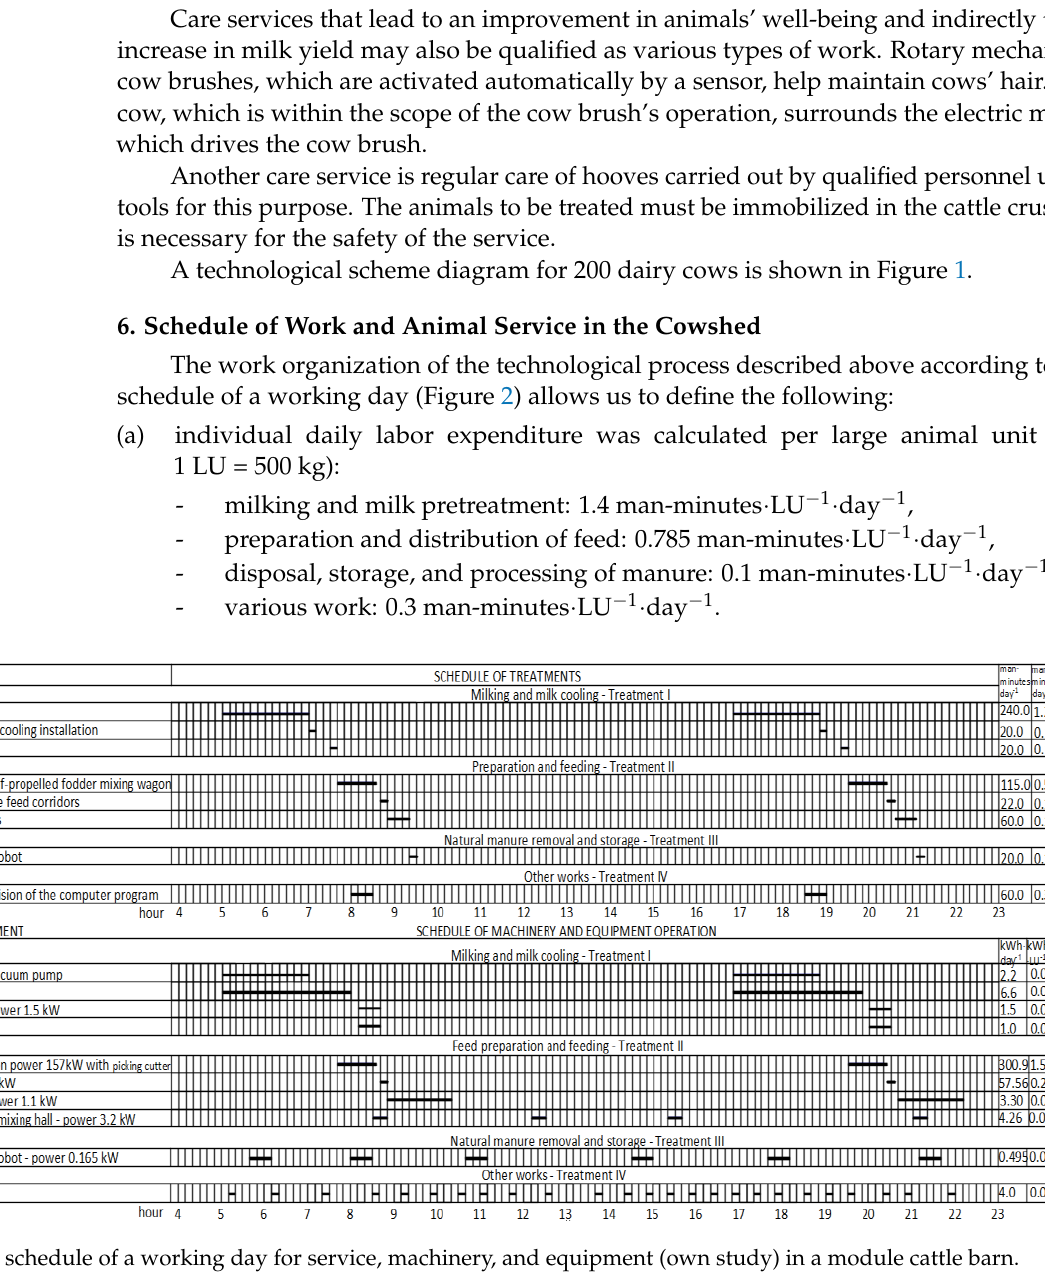
Labor inputs in the proposed module cattle barn are shown Figure 3.